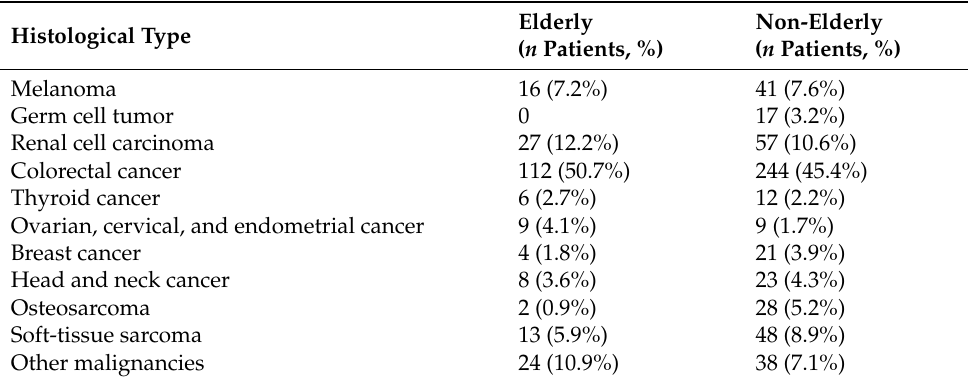
Table 2. Histological type of the primary